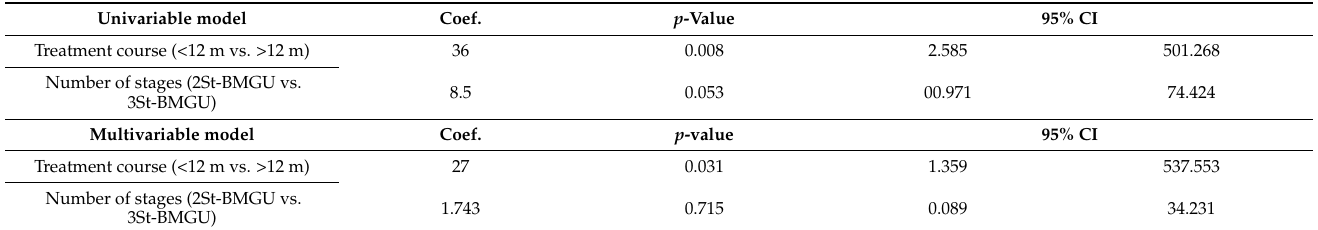
Table 3. Univariable and multivariable logistic regression models, predictors of treatment